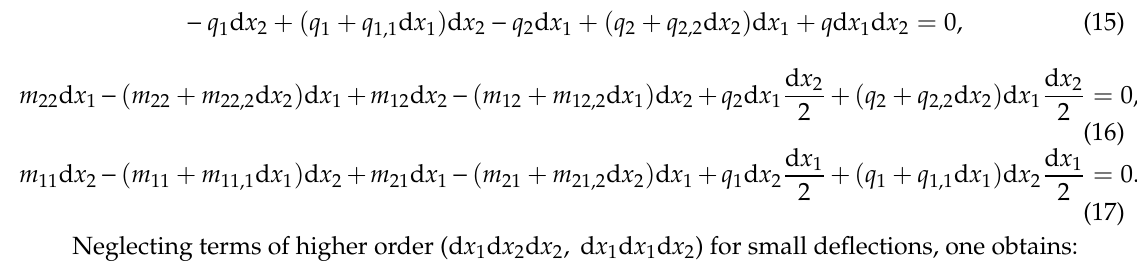
6 of 21 Table 1. Bending moments, torsional moments, transverse forces, and the corresponding boundary conditions. Length-related Quantities